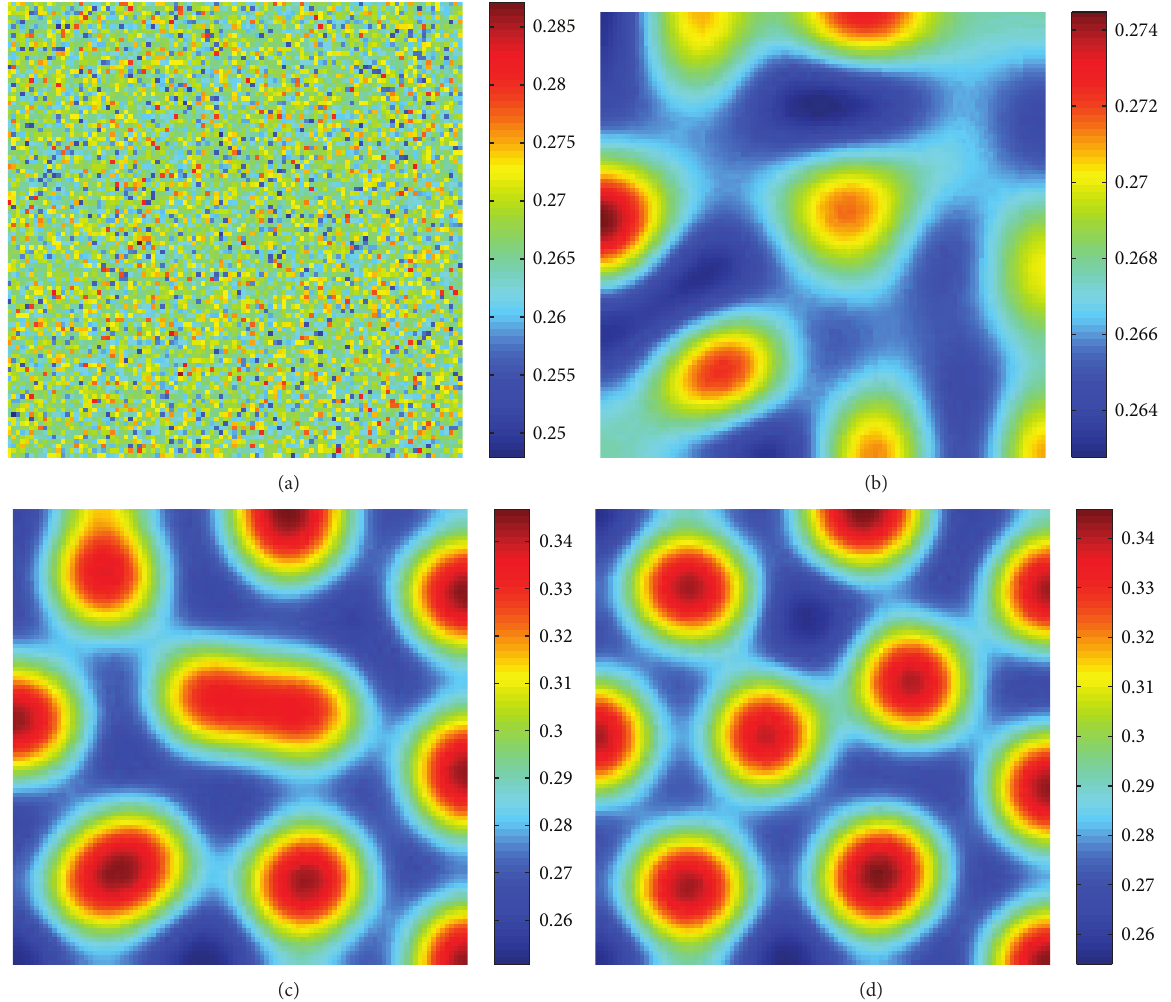
Figure 1: The formation of spots patterns of prey 𝑢 with parameters 𝑏 = 0.495, 𝑐 = 0.5, 𝑘 1 = 0.3, 𝑘 2 = 0.2, 𝑚 = 0.32, 𝑠 = 0.25, 𝑑 1 = 0.1 , and = 2 . Time: (a) 𝑡 = 0 , (b) 𝑡 = 300 , (c) 𝑡 = 1000 , and (c) 𝑡 = 3000 𝑑 2